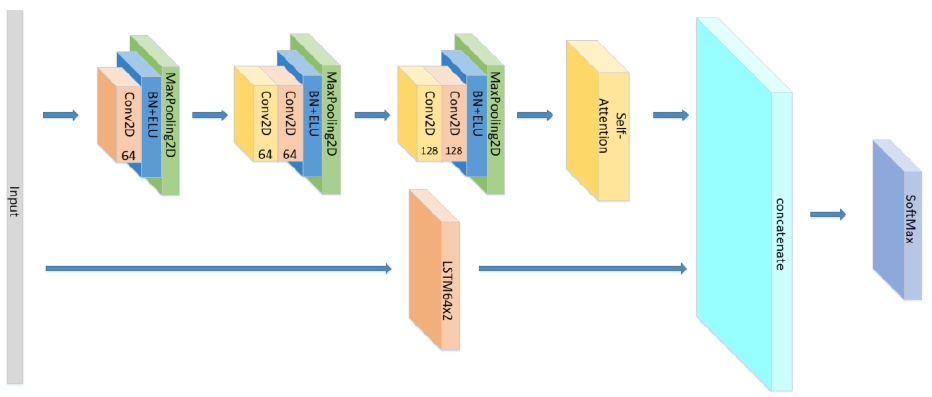
Figure 21. The structure of the CNN+Global-Attention//LSTM×2.